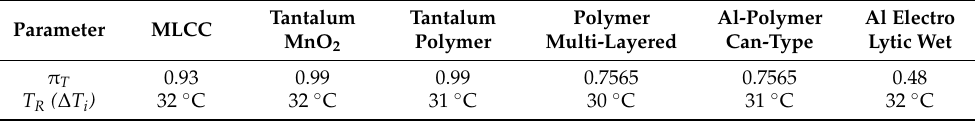
Table 1. Calculated parameters π T and ∆ T i function of capacitor’s technology.